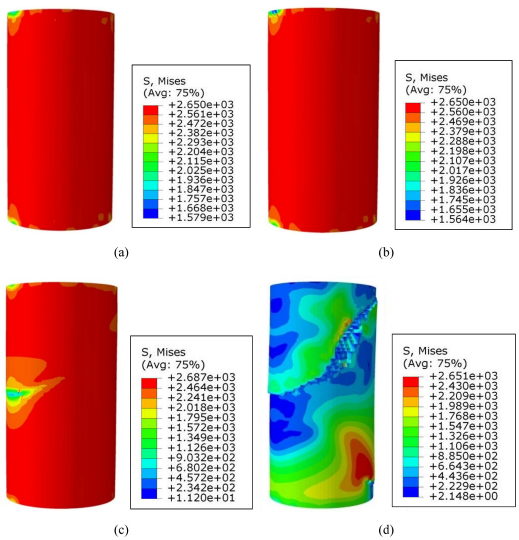
Figure 5. The Mises stress distribution of 3mm sample at different compressive strains, a) 3.81%, b) 3.82%, c) 3.83% and d) 3.84%.